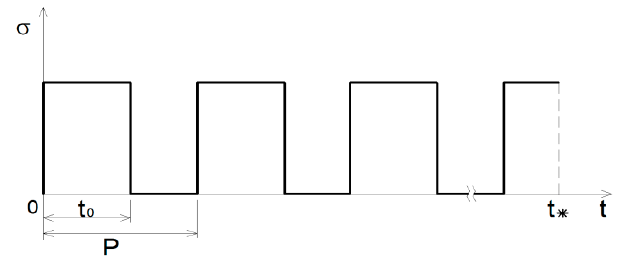
Figure 6. Scheme of cyclic loading.